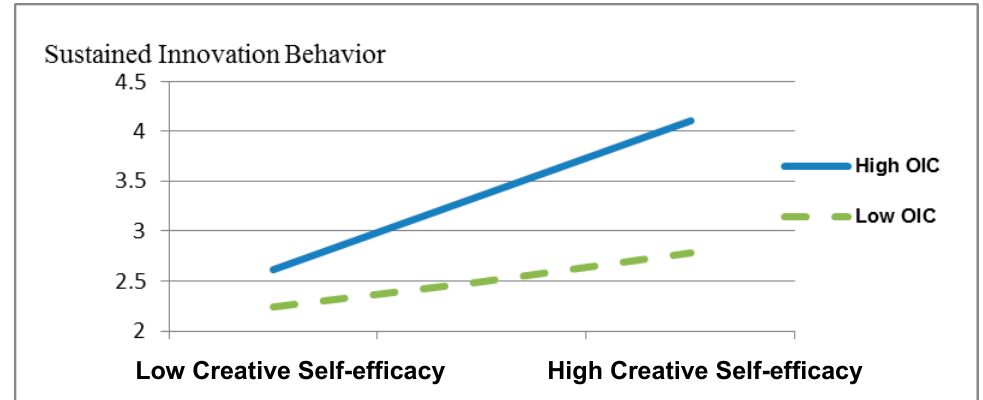
Figure 2. Cross-level moderation effect diagram of the organizational innovation climate (OIC) showing the relationship between creative self-efficacy and sustained innovation behavior.